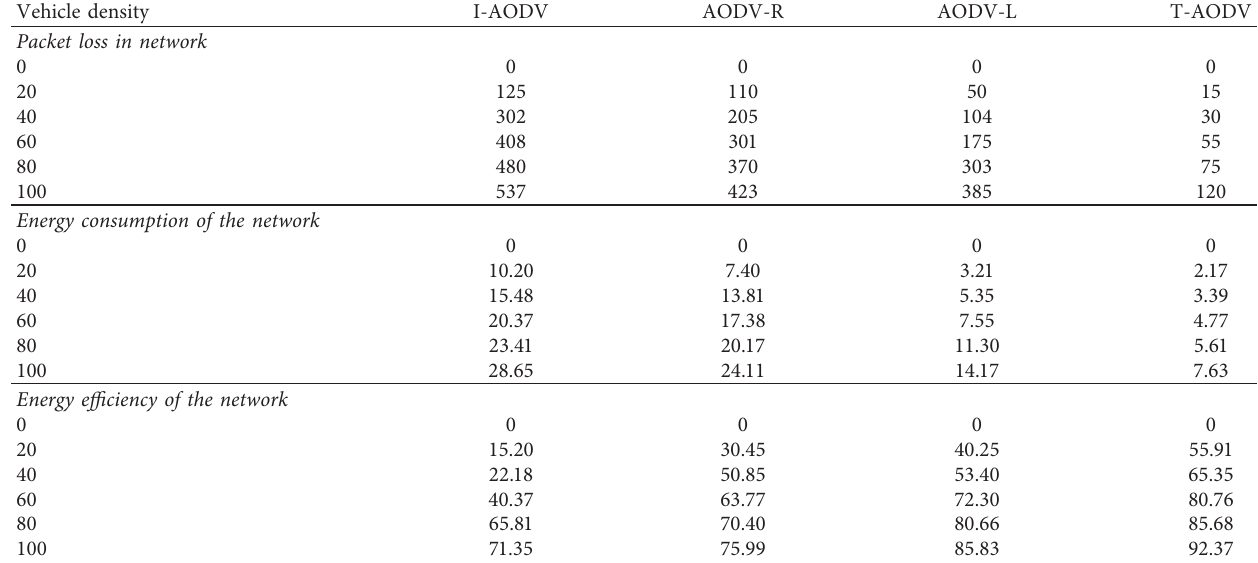
Table 5: Summary of network efficiency of different